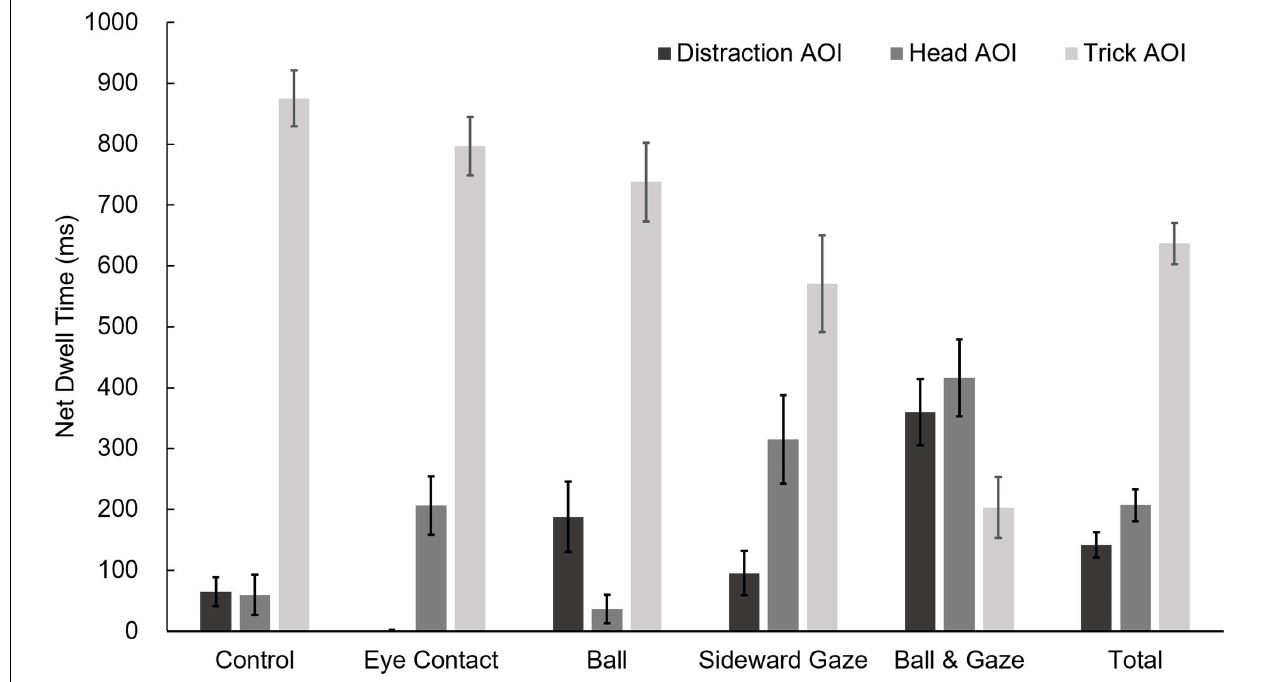
FIGURE 5 | Participants’ net dwell times on the three AOIs (see Figure 4) in the five experimental conditions during the 19-to-20-s period of the first presentation of the videos. Error bars denote standard errors of the mean. Note that in the Eye Contact group, only two persons looked at the distraction AOI during the relevant timeframe for a few milliseconds each. In the Eye Contact condition (as well as in the control condition) no attempt of misdirection in the direction of the distraction AOI was made. When interpreting dwell times for the head AOI, be aware that in the Control and Ball conditions no social cues were